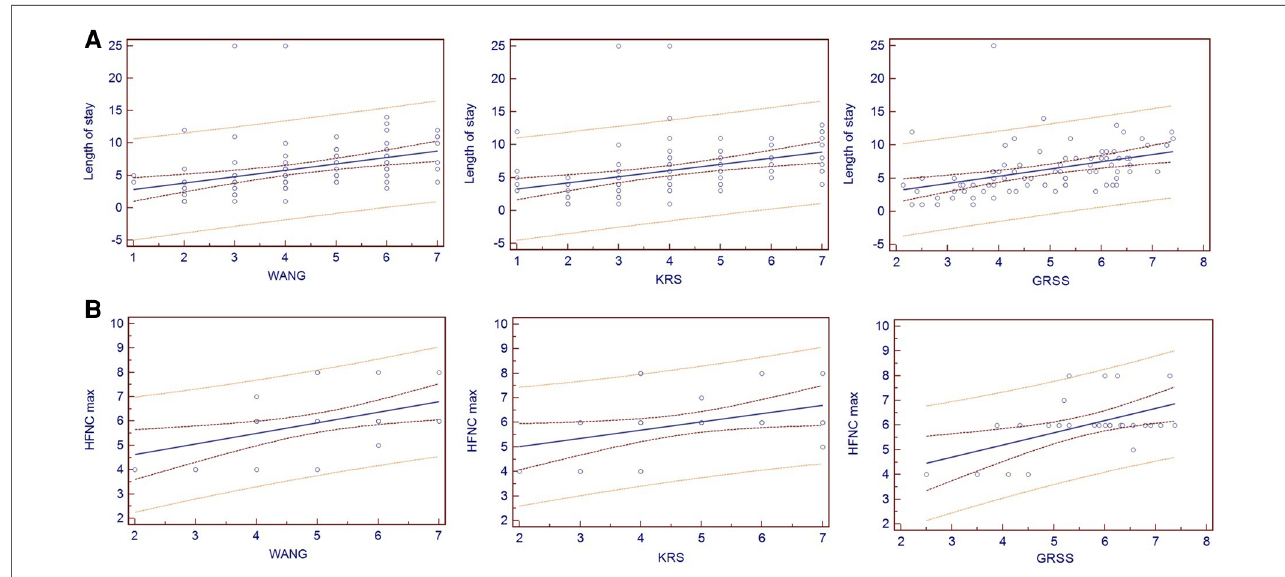
FIGURE 2 Spearman ’ s correlation of the three different scores with the length of stay ( Figure 2A ) and the maximum fl ow used with high- fl ow nasal cannulas ( Figure 2B